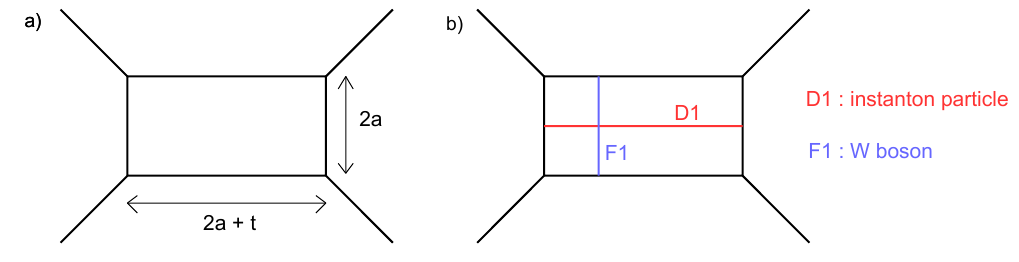
Figure 1 . a) Brane realization of the pure SU(2) theory. b) Half-BPS strings excitations for W-bosons and instanton